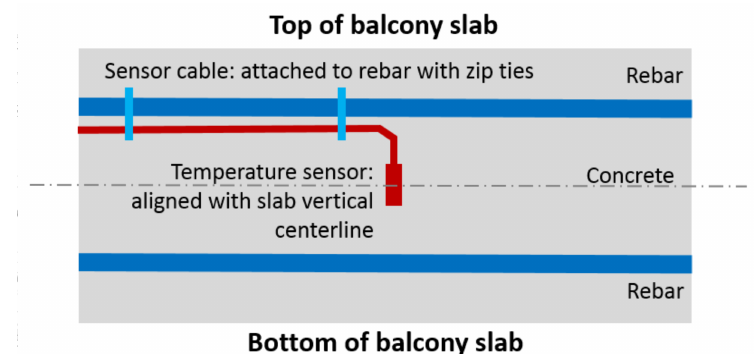
Figure 4. Cross section through a typical